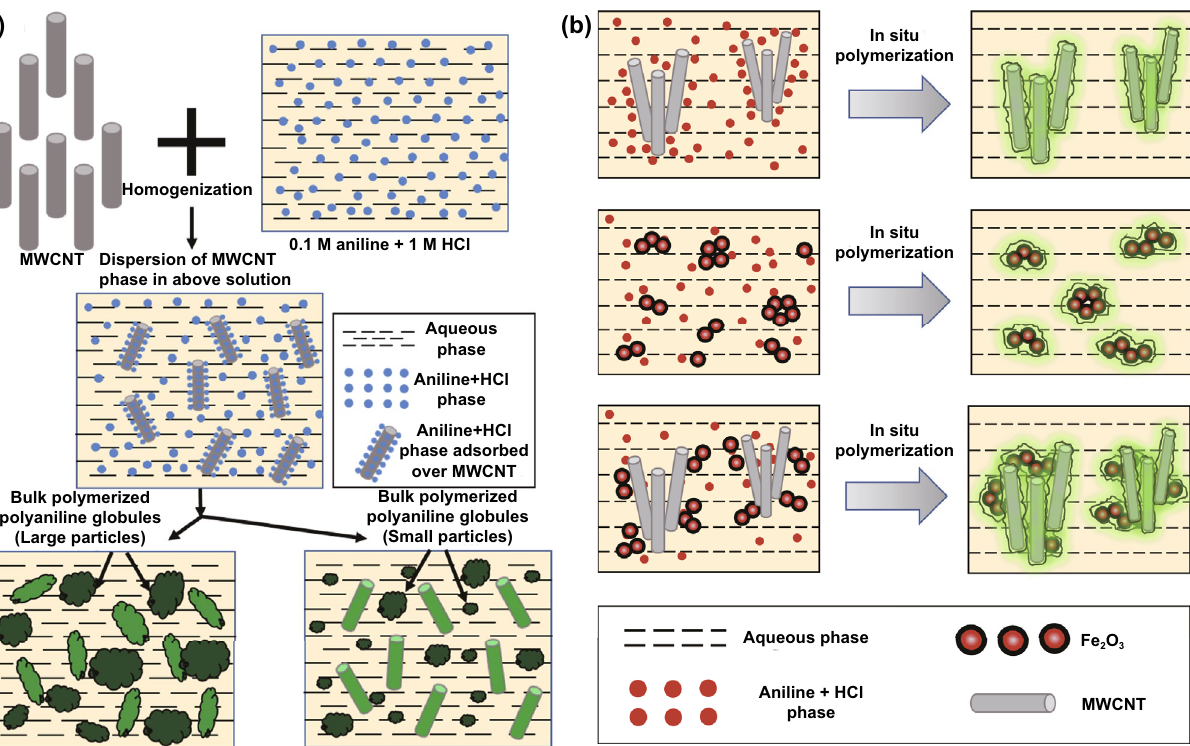
Fig. 6 Schematic illustrating the fabrication of a PANI-MWCNTs and b PANI-MWCNTs/Fe 2 O 3 composites [86, 87]. Copyright © 2008 Else-